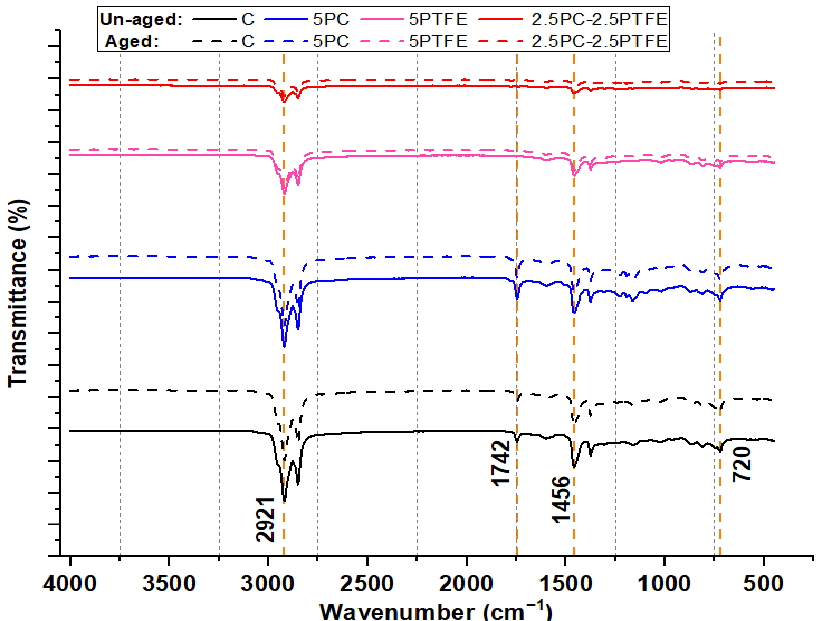
Figure 17. FTIR spectroscopy spectra of RTFOT aged specimens relative to bitumen specimens before aging process.